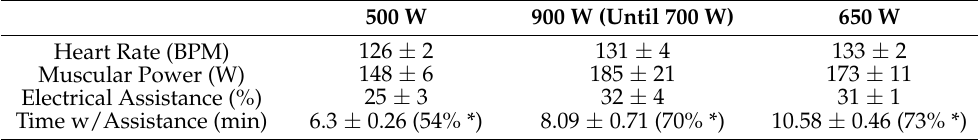
Table 5. Overall results using the PD algorithm.